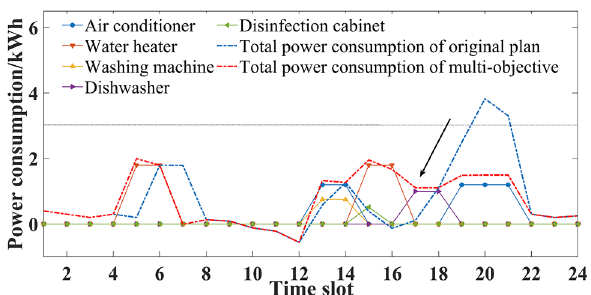
Figure 7. Power consumption plan of multi-objective optimization in summer.